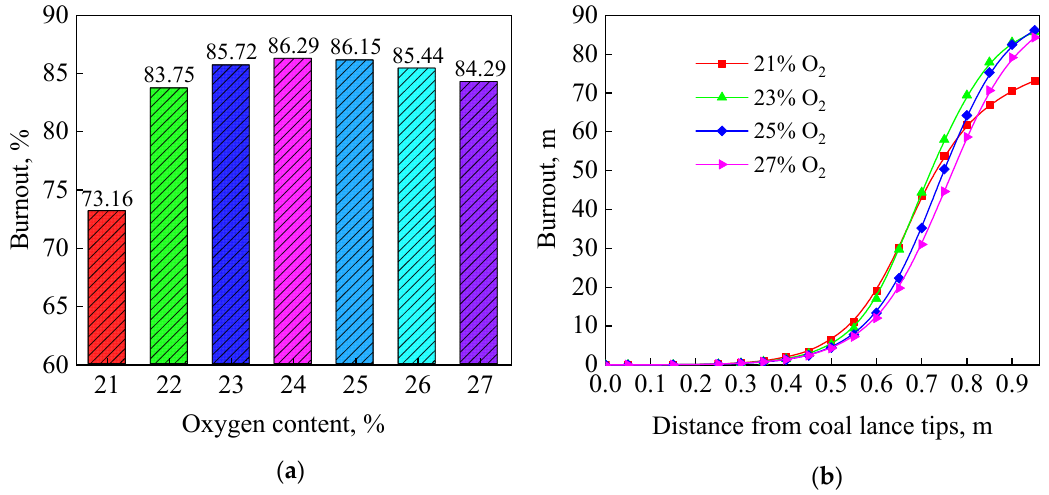
Figure 8. Effect of oxygen content under targeted oxygen enrichment: ( a ) final burnout; ( b ) combustion process.